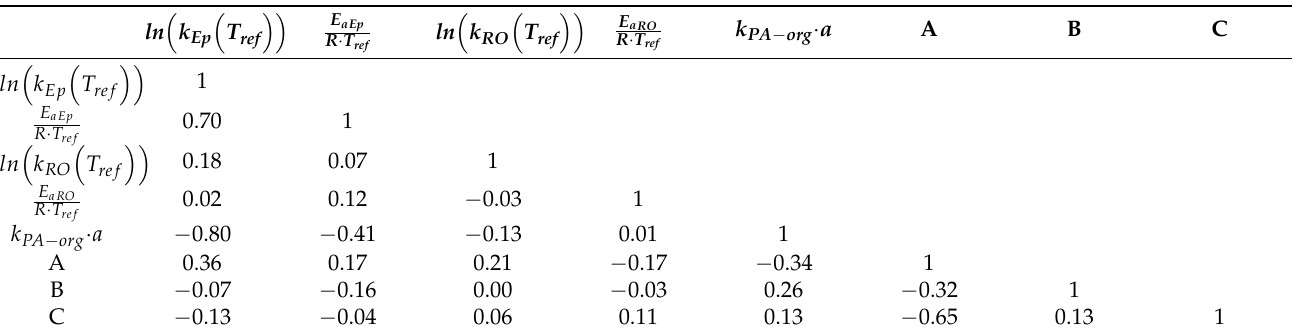
Table 6. Correlation matrix of estimated parameters.